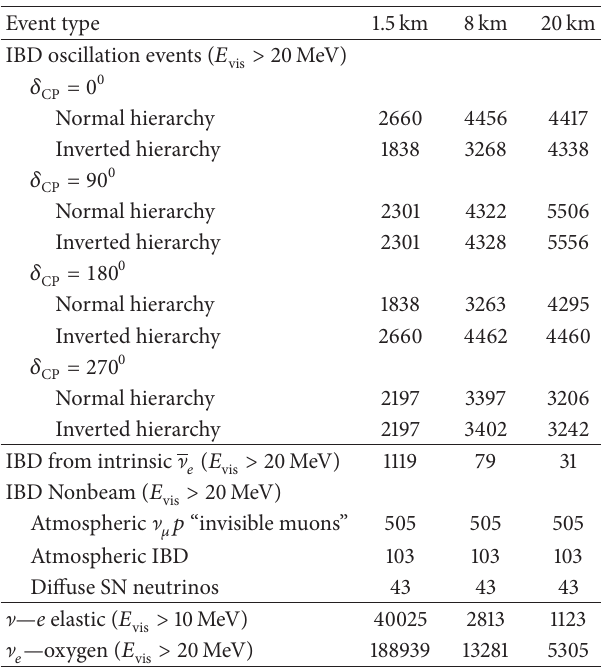
Table 7: DAE 𝛿 ALUS@Hyper-K 1 𝜎 measurement uncertainty